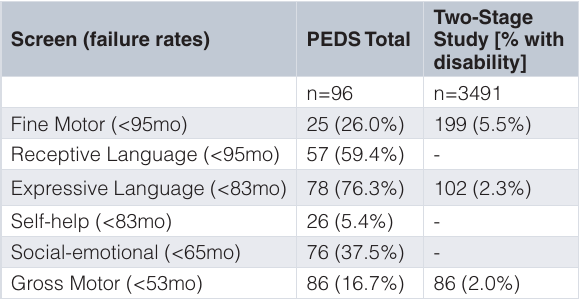
Two-Stage Study [%